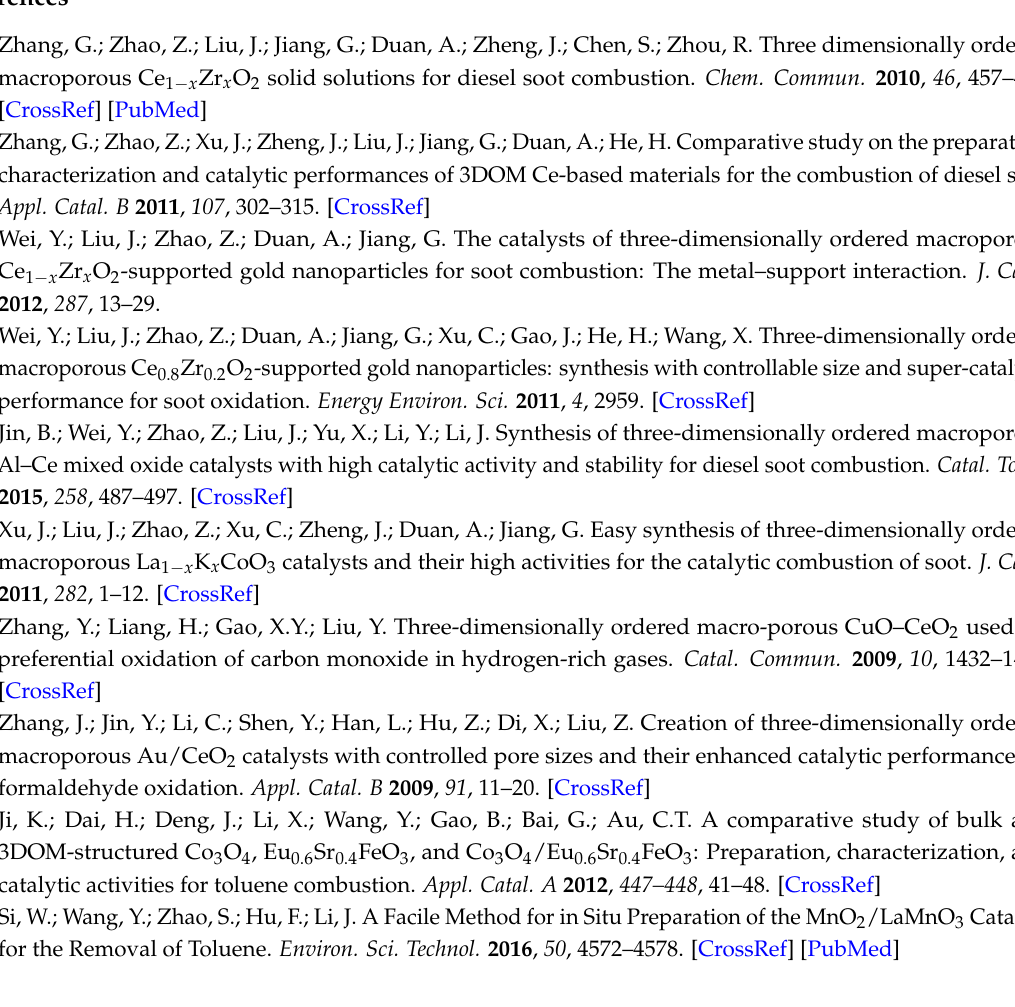
Figure S1: XPS spectra in the energy range of Ce 3d. Figure S2: XPS spectra in the energy range of Pr